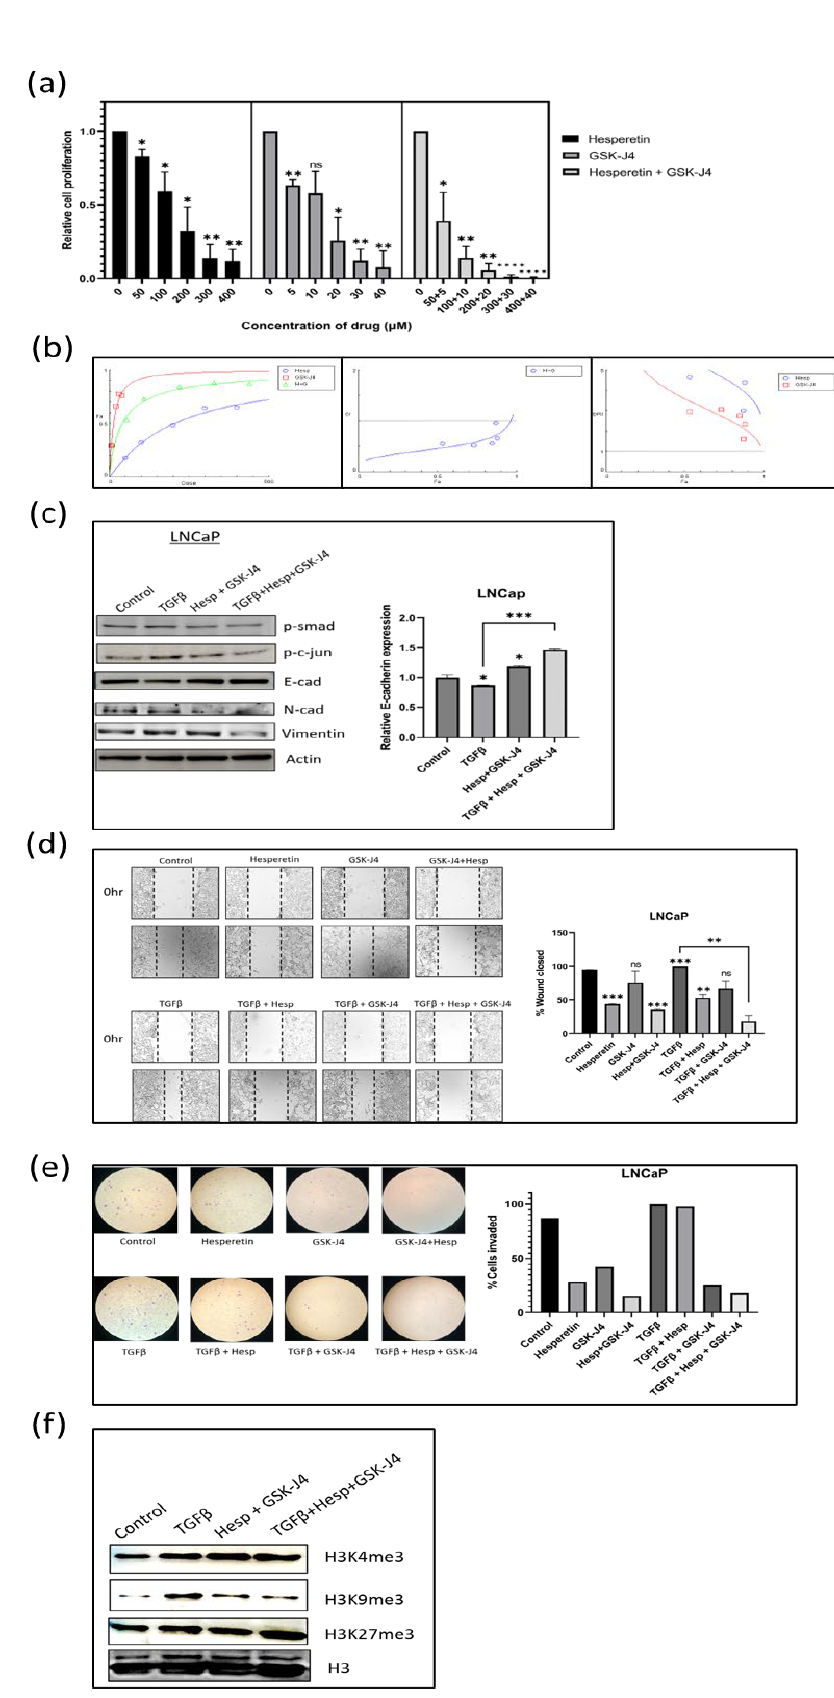
Figure 4. ( a ) MTT assay in LNCaP cell line to determine the effect of GSK-J4 and hesperetin alone and, in combination, on cell proliferation. DMSO was taken as the vehicle control. ( b )